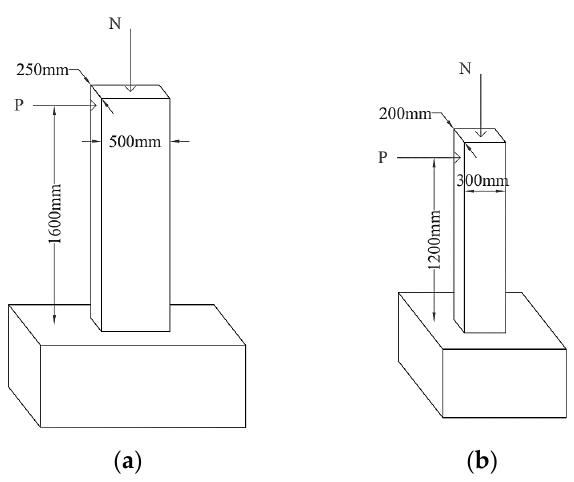
Figure 1. Dimensions of the RC columns ( a ) of [1] and [44]; ( b ) of [3]. The 3D FE pseudodynamic analysis approach may reproduce any random load or displacement history over time. While the experimental columns were subjected to successive cycles of top horizontal displacements of increasing value, the FE analyses followed a monotonically increasing top horizontal displacement. This approach saved valuable analysis time while maintaining high reliability. Figure 2a–c presents the validation of the pseudodynamic monotonic analytical base shear force–displacement curves when compared against the experimental ones (the envelope P- δ curves of the original experimental response for push (+) and push ( − ) directions) of columns R-P2L0, R-P2L1 and R-P2L3 with no lap splices, 15 d bL lap length and 30 d bL lap length, respectively. The experimental values for push (+) and push ( − ) direction and the analytical values are indicated as “experimental push (+)”, “experimental push ( − )” and “analytical”, respectively. Figure 2d presents the analytical curves comparatively. The dashed lines mark the 20% drop in the maximum values of the analytical and experimental base shear (for both directions, push + and − ), considered as the lowest acceptable threshold of base shear at failure according to several seismic codes. In particular (see Table 1), for column R-P2L0 without lap splices, these experimental limit values for push (+) and ( − ) are 0.8 × 240 = 192 kN (black dashed line) and 0.8 × 194 = 155.2 kN (grey dashed line), respectively. The analytical prediction is 0.8 × 217.7 = 174.2 kN (red dashed line), being around the average of experimental values per cycle. Table 1. Comparative results for specimens R-P2L0, R-P2L1 and R-P2L3 with different lap lengths.